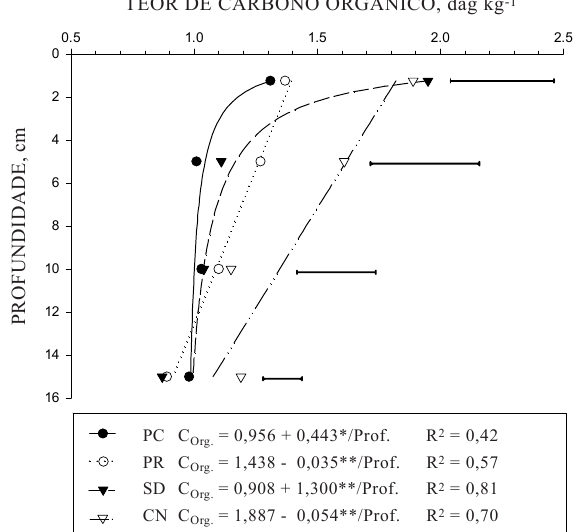
Figura 1. Teor de carbono orgânico, em diferentes profundidades do solo sob diferentes sistemas de manejo. Os pontos representam as médias sob diferentes sistemas de manejo dos tratamentos (n = 3). As barras horizontais indicam diferen- ças mínimas significativas entre tratamentos em uma mesma profundidade, calculadas pelo tes- te de Duncan a 5 %. * e **: significativos a 5 e 1